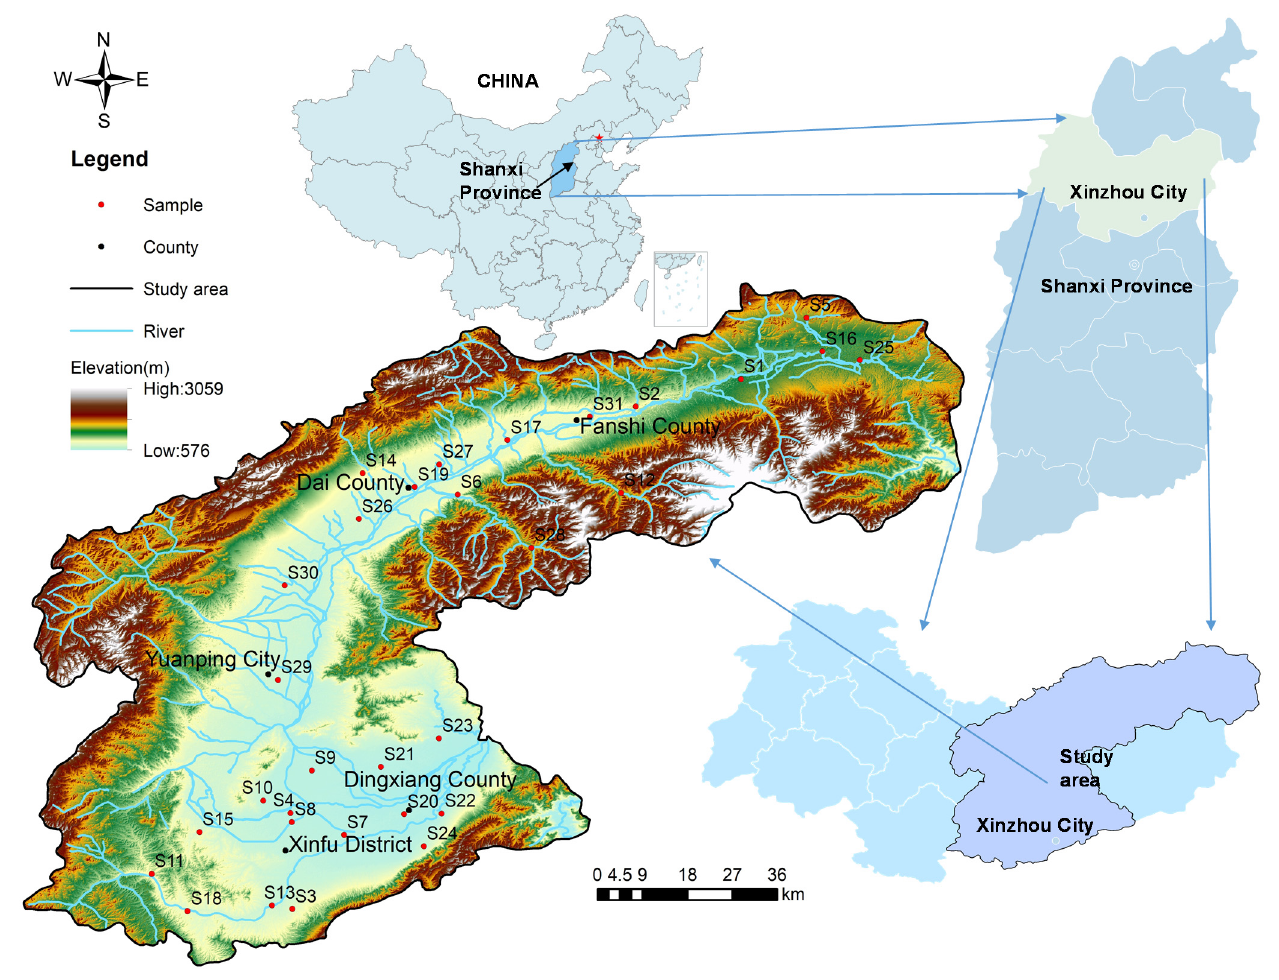
Figure 1. Study area and groundwater sampling sites.